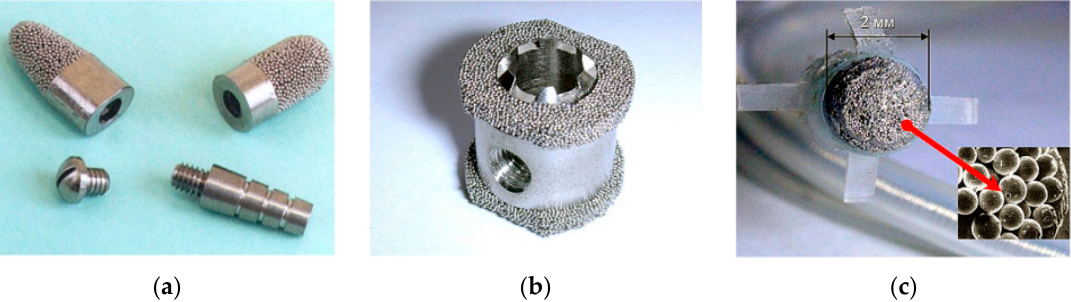
Figure 12. Medical devices of porous titanium made by EDC: ( a ) dental implants; ( b ) vertebrae implant; ( c ) porous head endocardial electrode. Reprinted with permission from ref. [42] Copyright 2016 Elsevier.